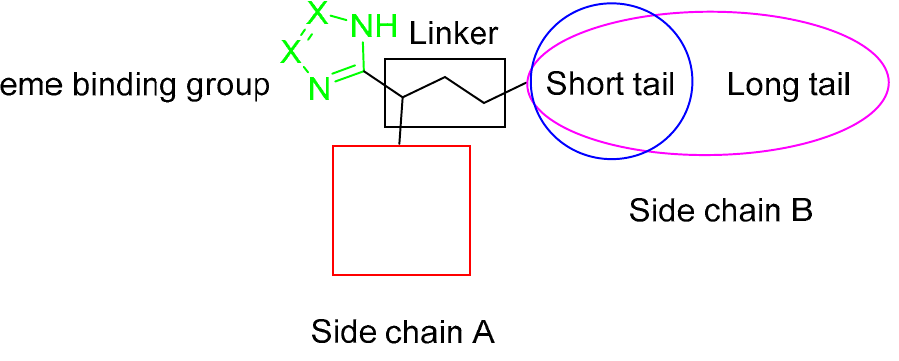
Figure 1. Structural modifications of azoles .